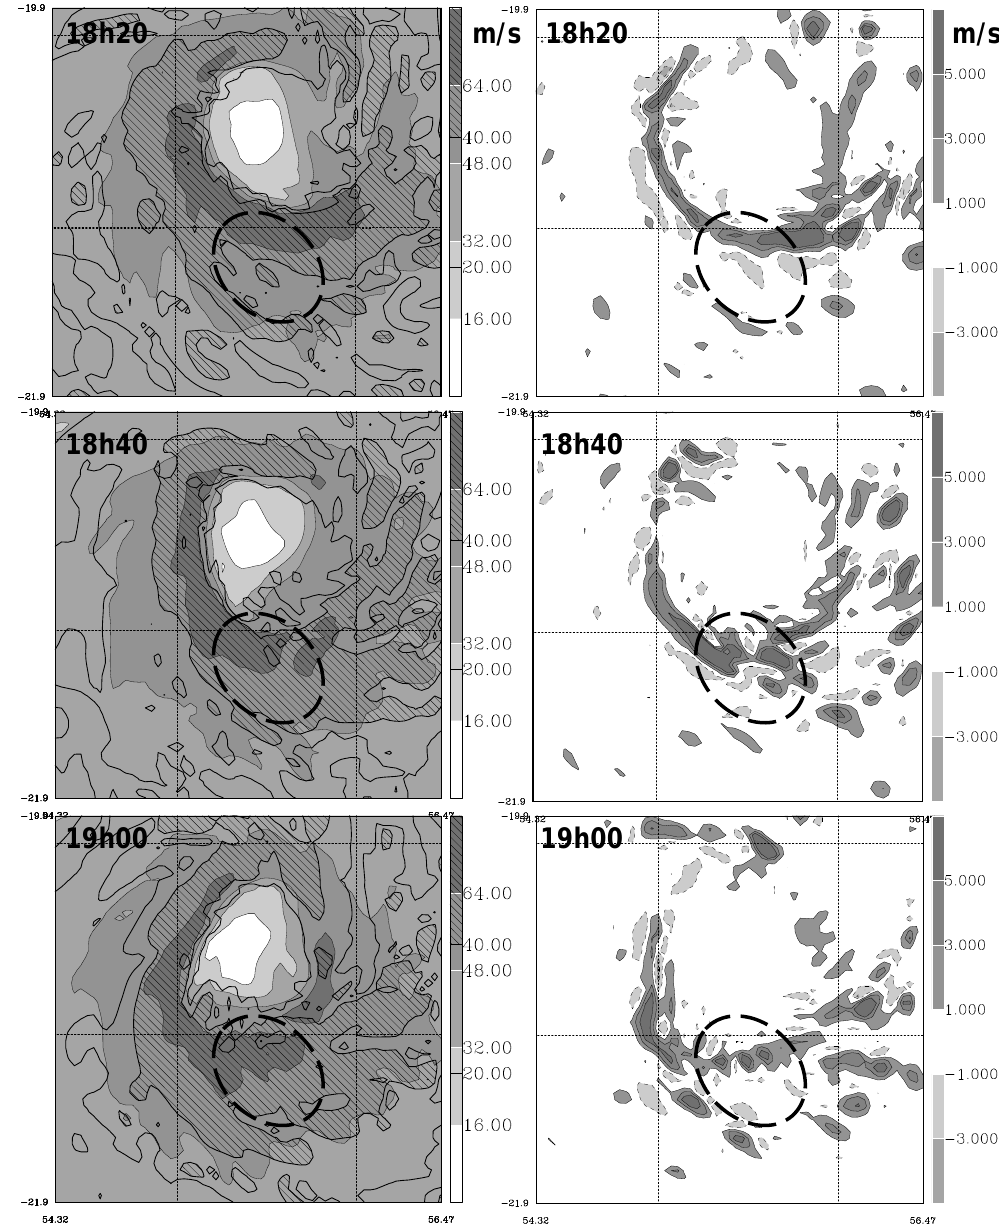
Fig. 8. Left panels: horizontal wind speed (shaded, ms − 1 ) and radar reflectivity (20 and 40dBZ contours, hatched zones denote values > 40dBZ) from the 4-km model of experiment “ Ocean ” at 1000m altitude, every 20min from 18:20 to 19h; right panels: as left panels, except for vertical velocity values (shaded, ms − 1 ) at 5000m altitude. The dashed line contour indicates the location of R´eunion island.